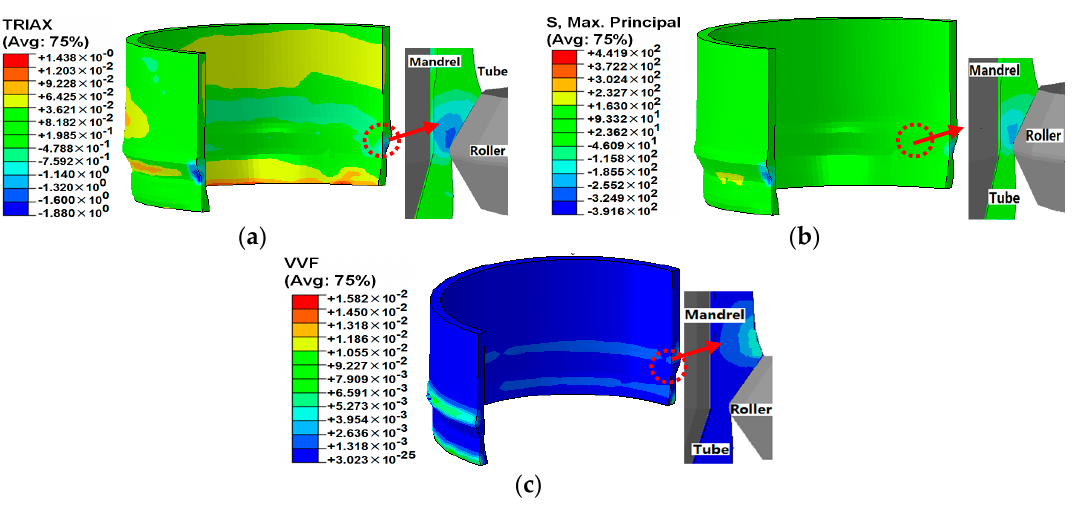
Figure 11. Distributions of ( a ) stress triaxiality; ( b ) maximum principal stress and ( c ) VVF in spun